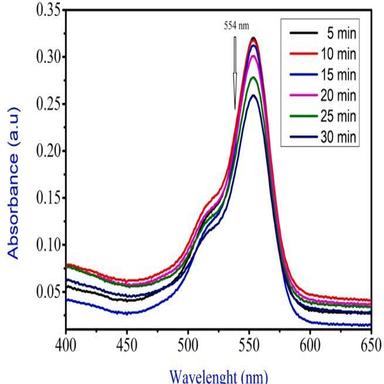
UV-Visible Spectra of Rhodamine B (RhB) Solution Subjected to Photoirradiation with the Fe-GO Nanocomposite at Different Time Intervals under Sunlight Irradiation in Water.